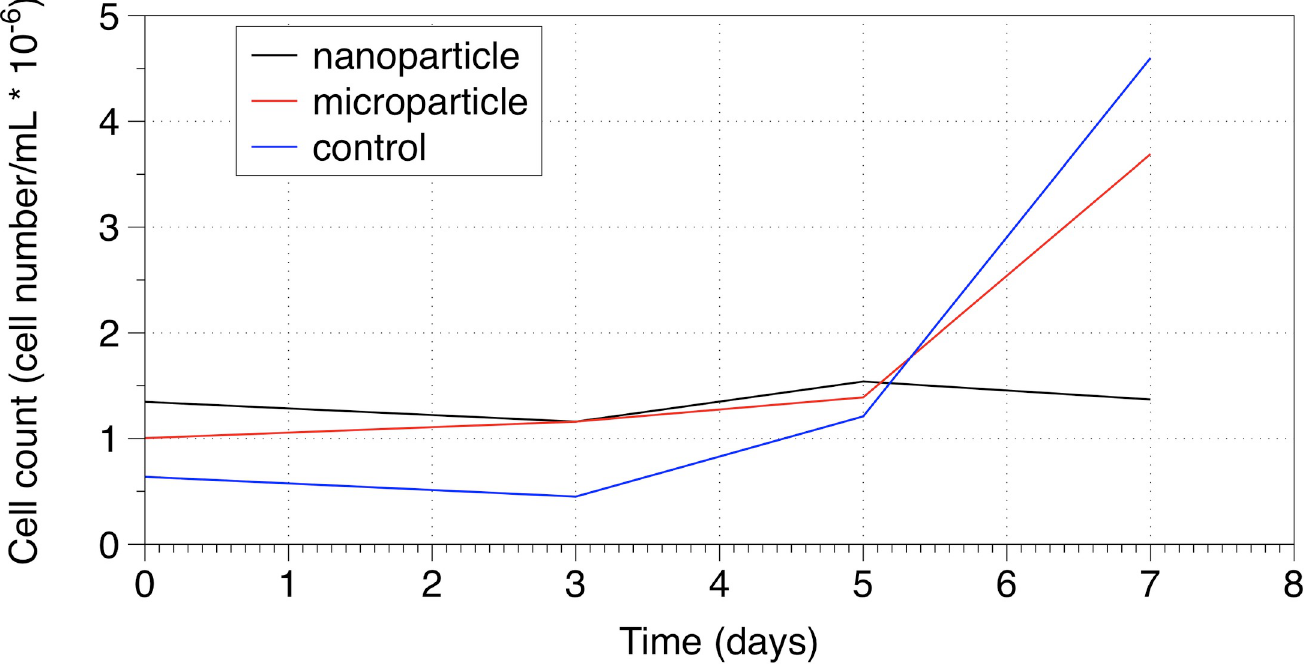
Fig 2. Viability analysis of Synechococcus sp . PCC 7002 exposed to polyethylene nanoparticles and microparticles over a period of 7 days.